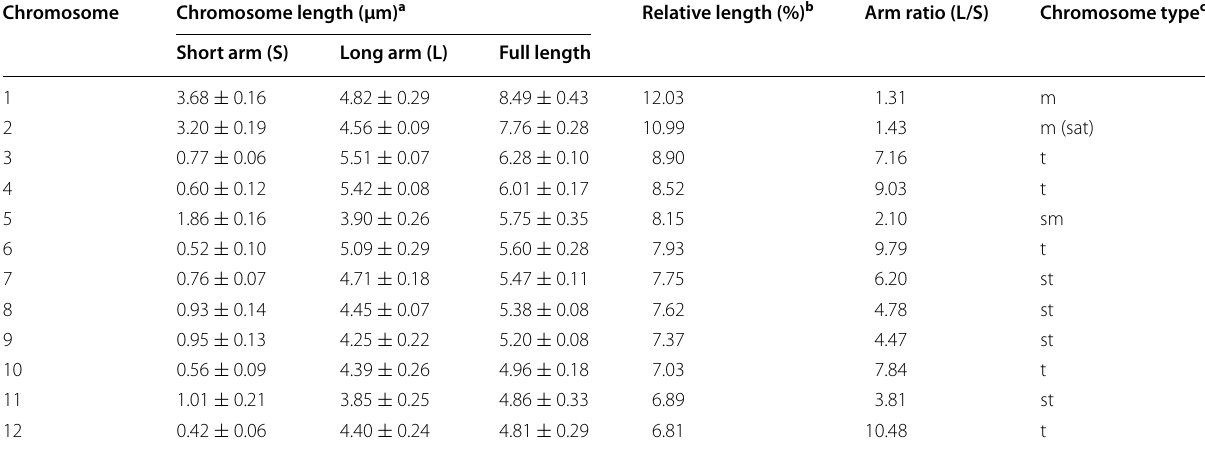
a The data is an average from three individuals b